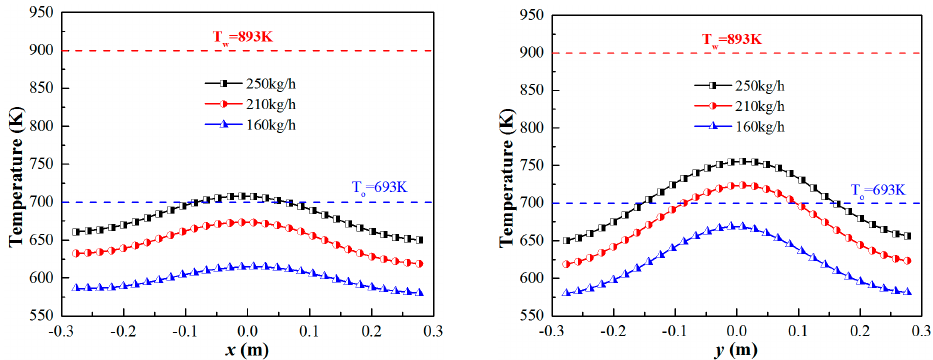
Figure 11. Temperature along the x line and y line when the extension distance was 400 mm.